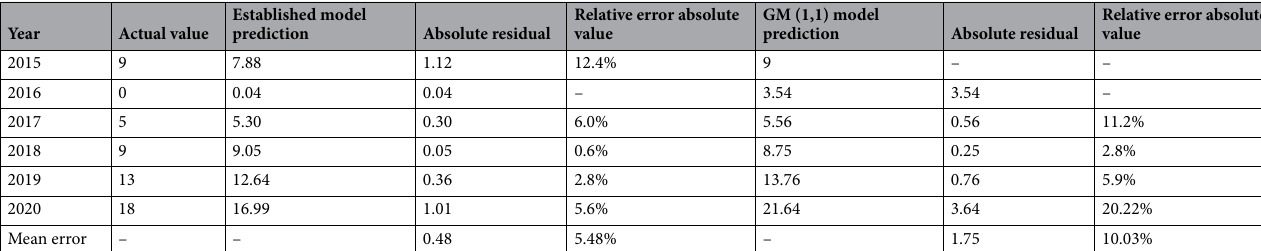
Table 11. Comparison of accident death toll prediction